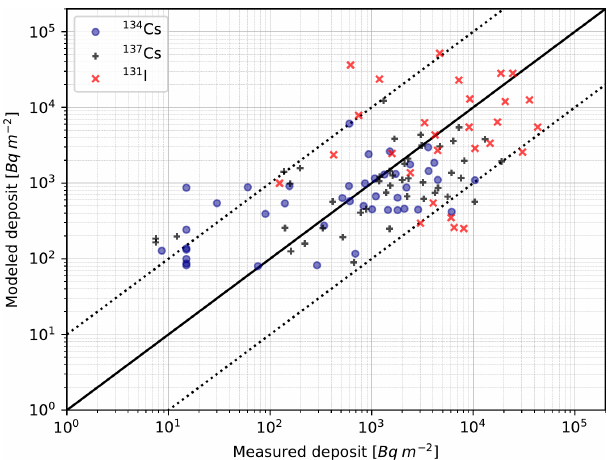
Figure 9. Comparison between measurements and Chernobyl- 1986 test deposit results of 137 Cs, 134 Cs and 131 I at different loca- tions on 10 May 1986. The solid line represents one-to-one agree- ment between measured and modelled values. Lower and upper dashed lines represent factors of 0.1 and 10, respectively, from the one-to-one